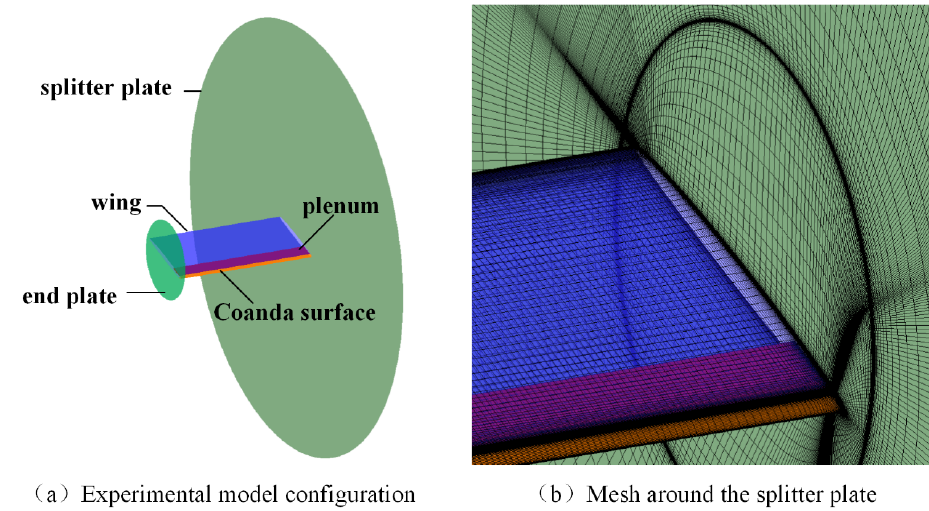
Figure 2. Experimental model configuration of CCW and structured grid around the splitter plate.